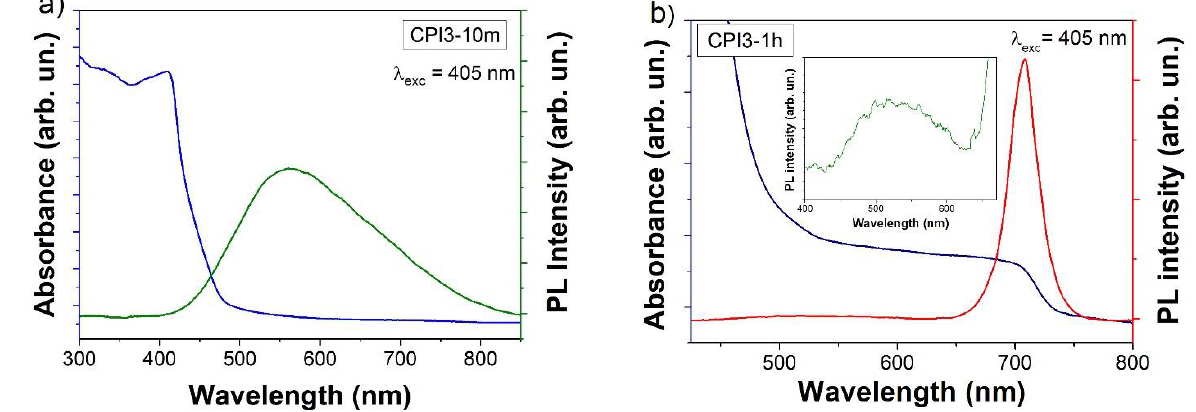
Figure 4. Absorption and steady-state luminescence spectra of the sample CPI3-10m, respectively in blue and green ( a ) and of the sample CPI3-1h, respectively in blue and red ( b ). The inset in figure ( b ) shows a zoom of the range 400–670 nm.